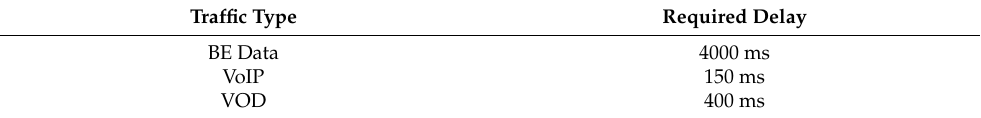
Table 4. Traffic QoS requirement